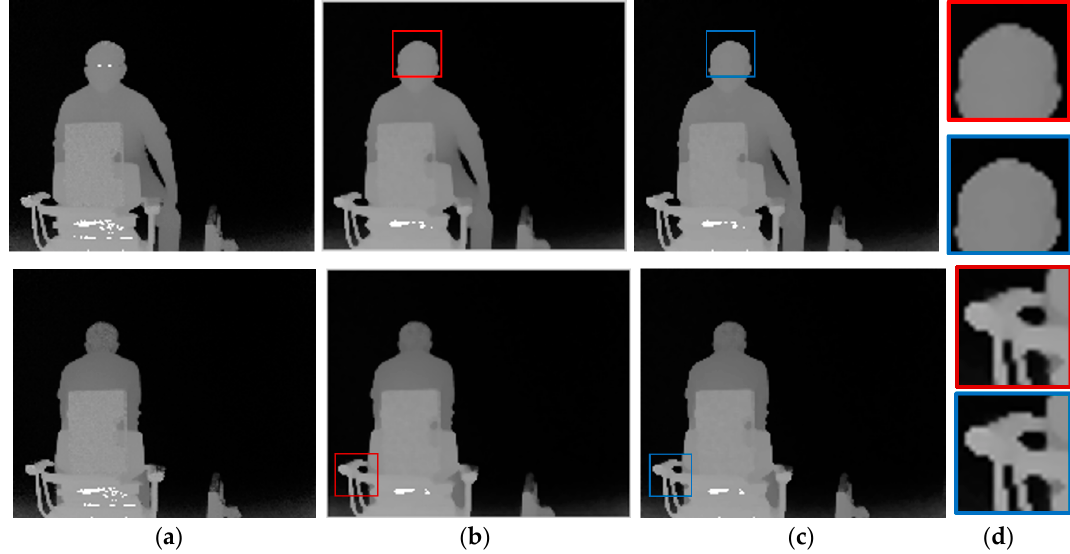
Figure 17. Experimental results with real-world data. ( a ) Original, ( b ) median filter, ( c ) SWMF (proposed), and ( d ) closed-up images.